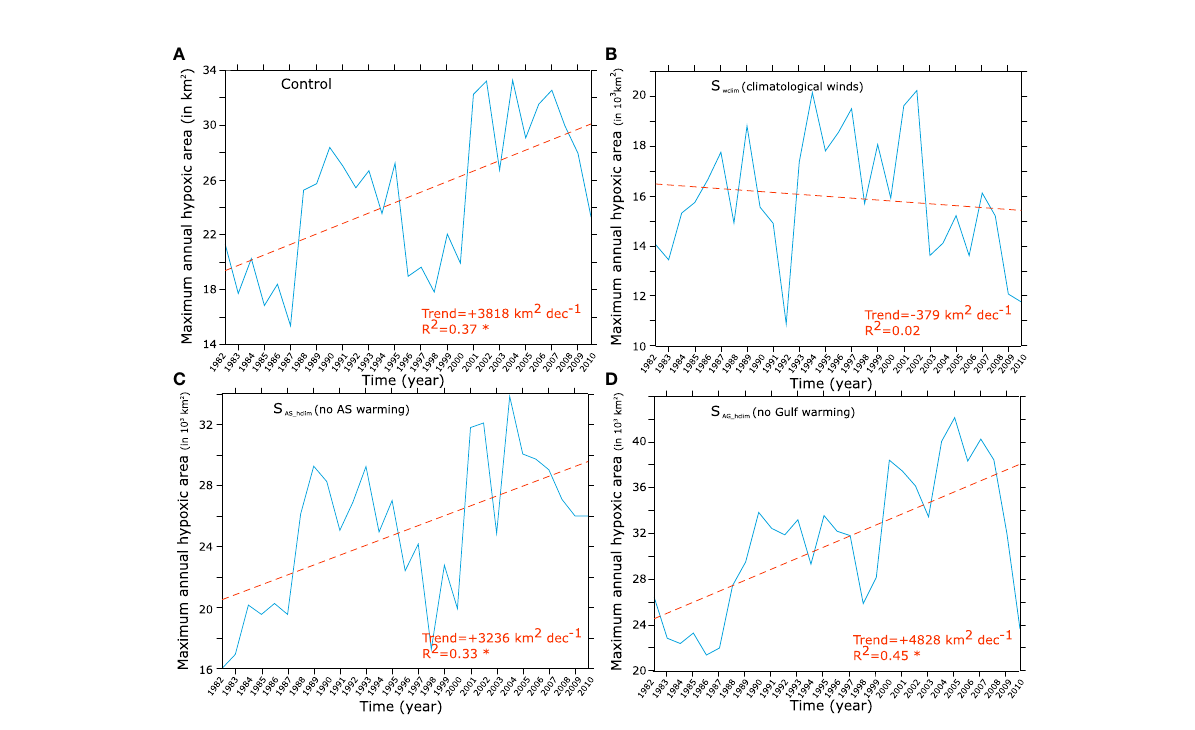
FIGURE 13 Evolution of the hypoxic area in the control and under different atmospheric forcing scenarios. Interannual anomalies and trends in bottom hypoxia annual maximum area (in 1000 km 2 ) as simulated in the control (A) , in absence of wind changes (i.e., S wclim ) (B) , in absence of warming over the Arabian Sea (i.e., S AS_hclim ) (C) and in absence of Gulf warming (i.e., S AG_hclim ) (D)